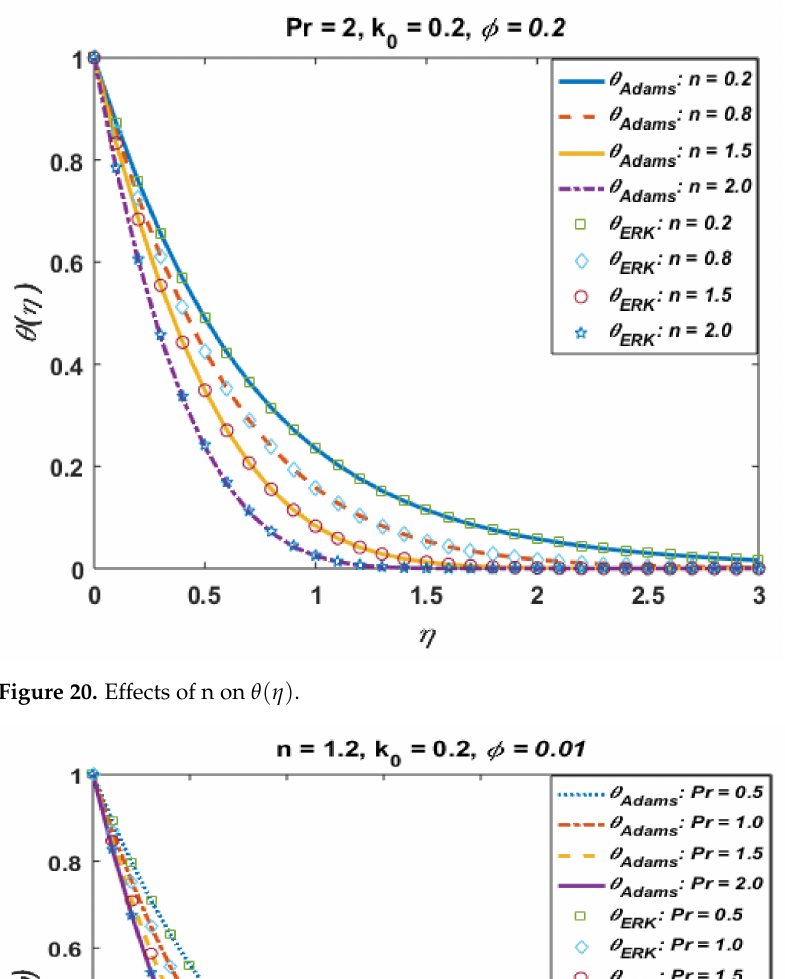
Figure 20. Effects of n on θ ( η ) .